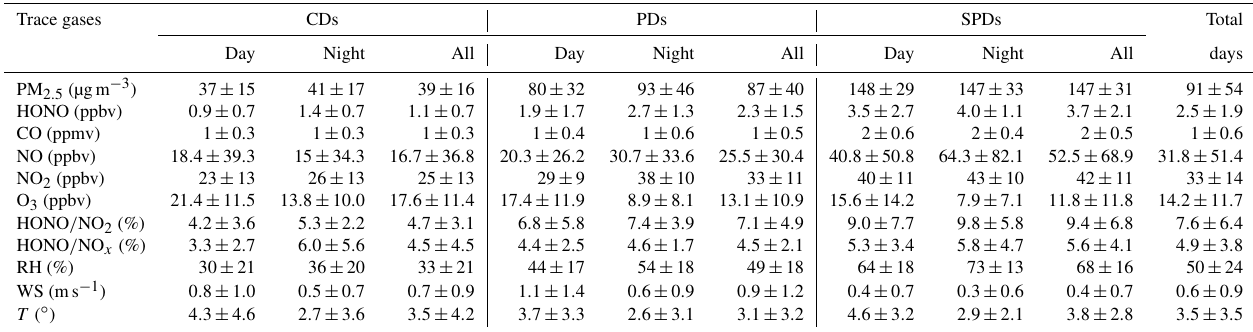
Figure 1. Temporal trends of hourly averages for T , RH, WD, WS, and PM 2 . 5 during the measurement. (The shaded areas are as follows: white for the CDs period; gray for the PDs period; and red for the SPDs period.) Table 1. Data statistics of HONO, PM 2 . 5 , NO 2 , NO, NO x , HONO / NO 2 , HONO / NO x , O 3 , CO, T , RH, and WS during the measurement period; mean value ± standard